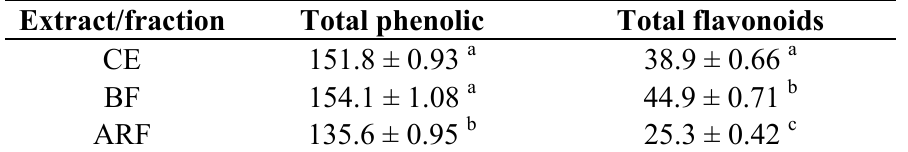
Table 1. Total phenolic a and total flavonoids b content in crude extract (CE), n -butanol fraction (BF) and aqueous residual fraction (ARF) of B. articulata